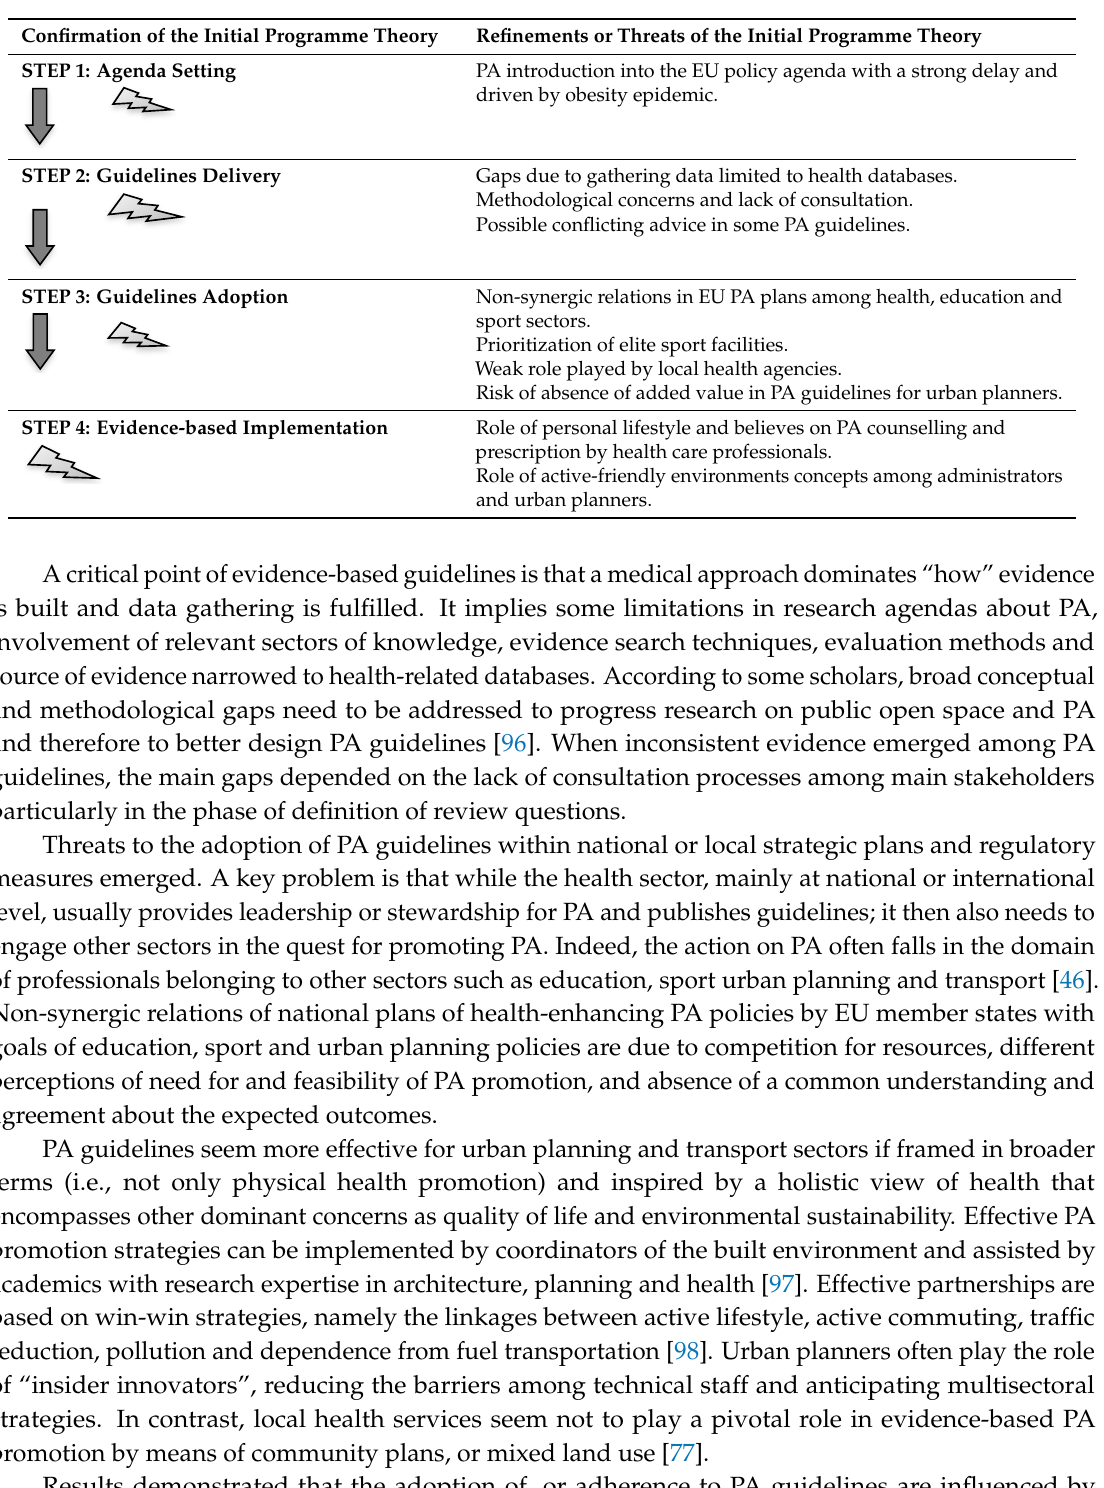
Table 2. Realist synthesis findings: threats, confirmation and refinements of the programme theory. Confirmation of the Initial